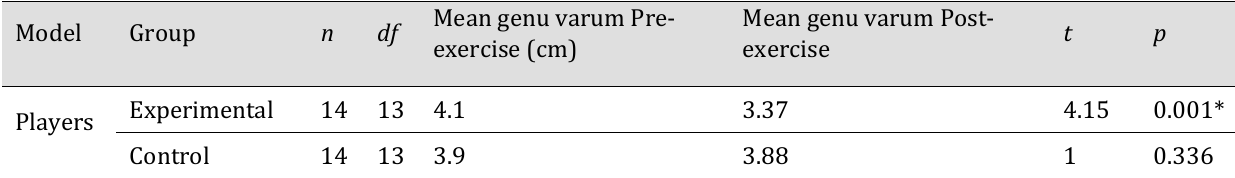
Table 5. Paired-sample t -test before and after the national academy of sports medicine NASM based corrective